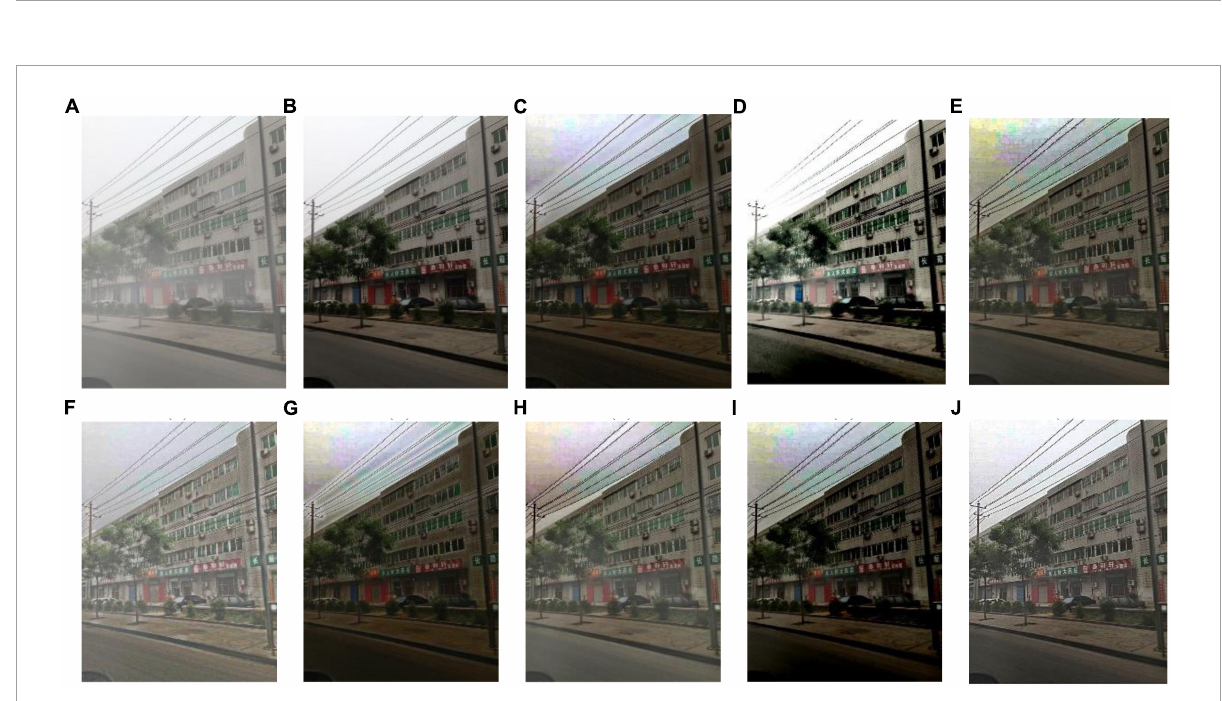
FIGURE8 Experimental results of different methods for Figure 1 : (A) input image; (B) ground truth; (C) dark channel prior; (D) Fattal et al.; (E) Meng et al.; (F) Tarel et al.; (G) Ehsan et al.; (H) Berman et al.; (I) Raikwar et al.; (J)